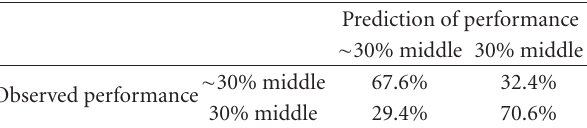
Table 4: Testing phase of the neural network predicting for middle 30% math